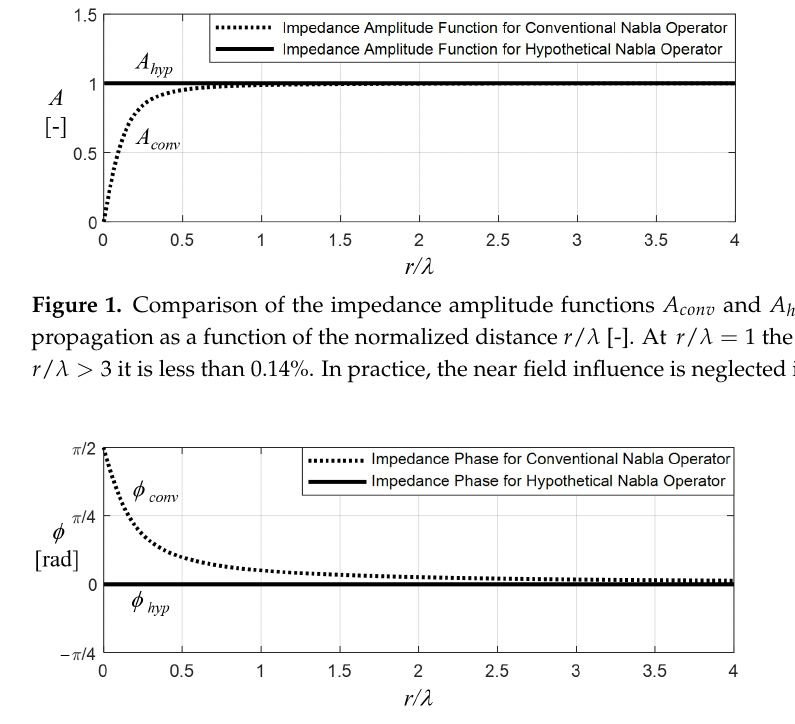
Figure 2. Comparison of the impedance related phases φ conv and φ hyp as a function of r / λ [-]. For r / λ = 1 the angular difference is 0.158 rad resp. 9° and for r / λ > 3 less than 0.053 rad resp.